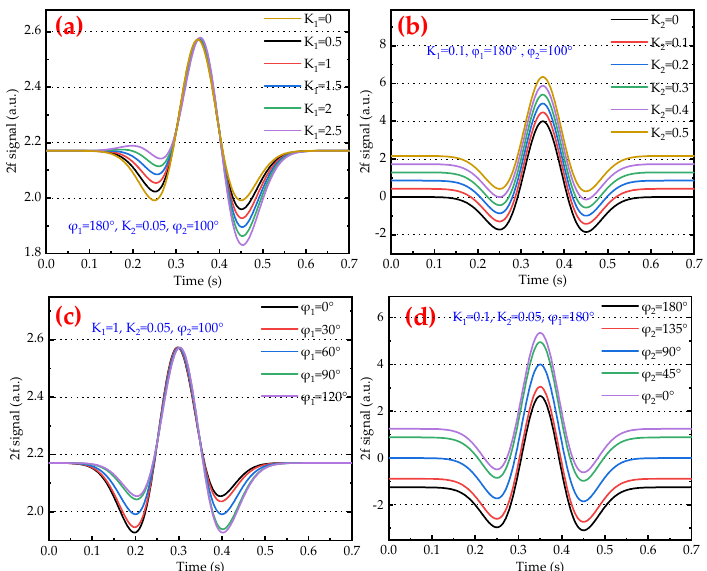
Figure 2. Simulation results of the effect of: ( a ) K 1 on the 2f signal, ( b ) K 2 on the 2f signal, ( c ) ϕ 1 on the 2f signal, and ( d ) ϕ 2 on the 2f signal.